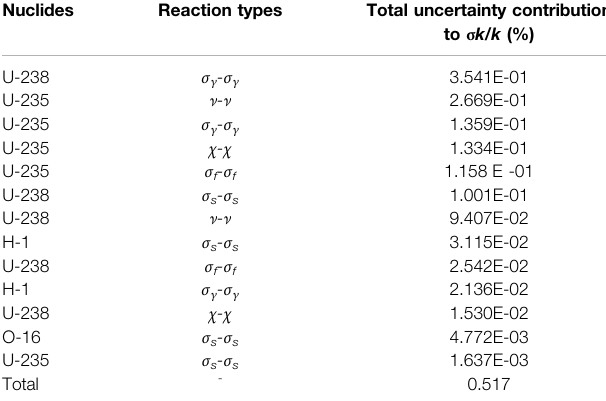
TABLE 5 | Total uncertainty